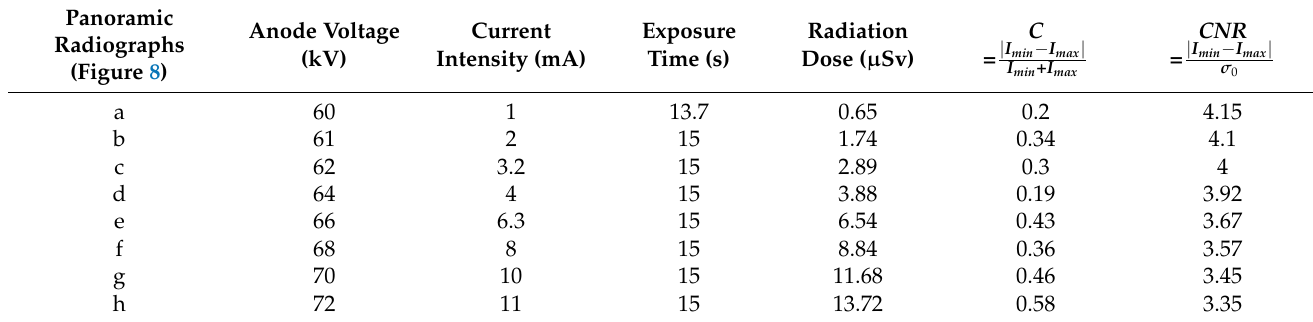
Table 2, of image parameters) using OCT images as reference, and we do not go beyond that because this would mean further increasing the radiation dose. Table 1. Panoramic settings before and during every step of the optimization process. Contrast ( C ) and contrast-to-noise- ratio ( CNR ) in the specific spots targeted on radiographs during the optimization process carried out using OCT. Panoramic